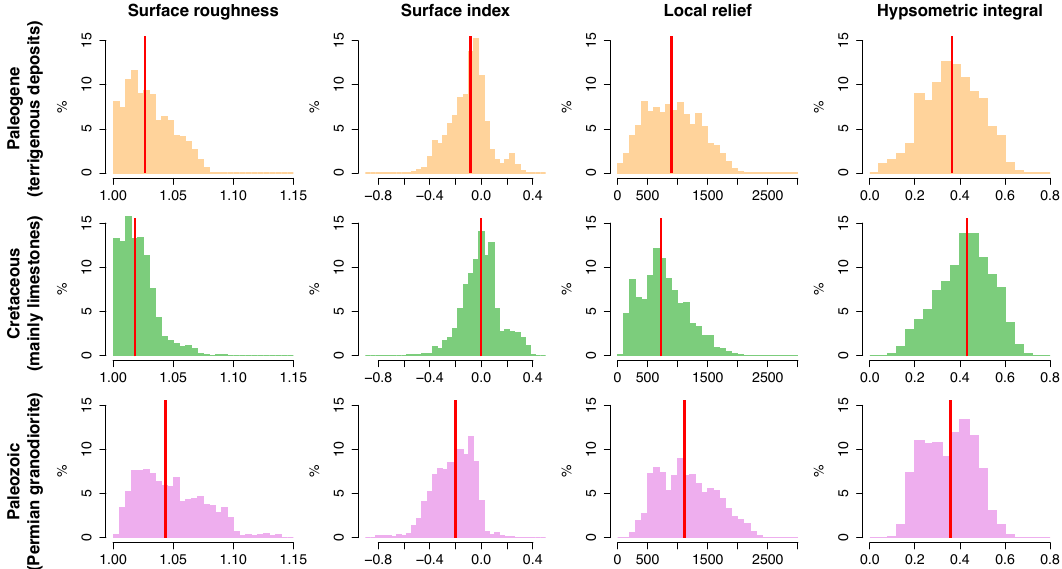
Figure 10. Distribution of morphometric indices for the main lithological groups of the Sierra Madre de Chiapas. Histograms are based on three sets of 5000 pixel values extracted from the morphometric maps (Figs. 7 and 8). Red line represents the median.